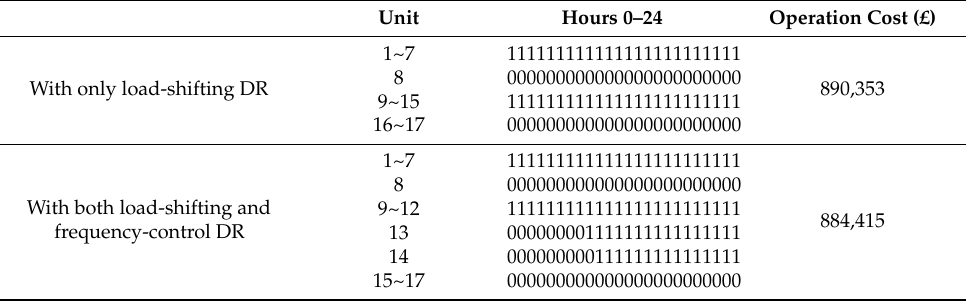
Table 3. Unit commitment of the 17-unit